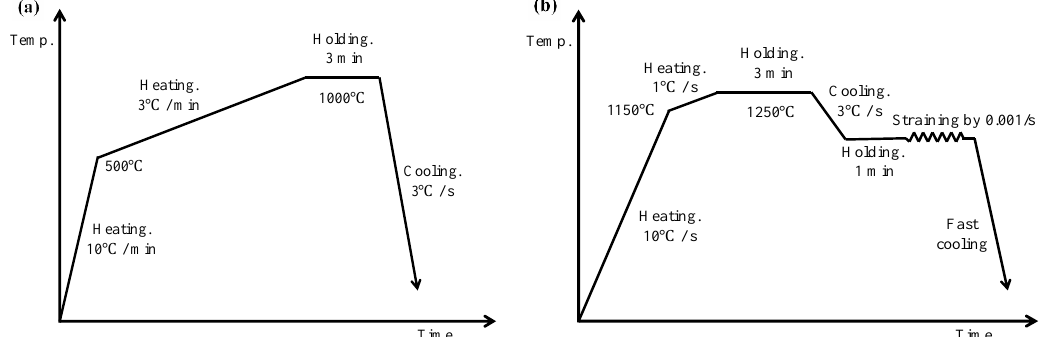
Figure 3. Thermal schedule used to study the critical phase transition and hot ductility. ( a ) Thermal schedule of the dilatometer test; ( b ) thermal schedule of the high-temperature tensile test.